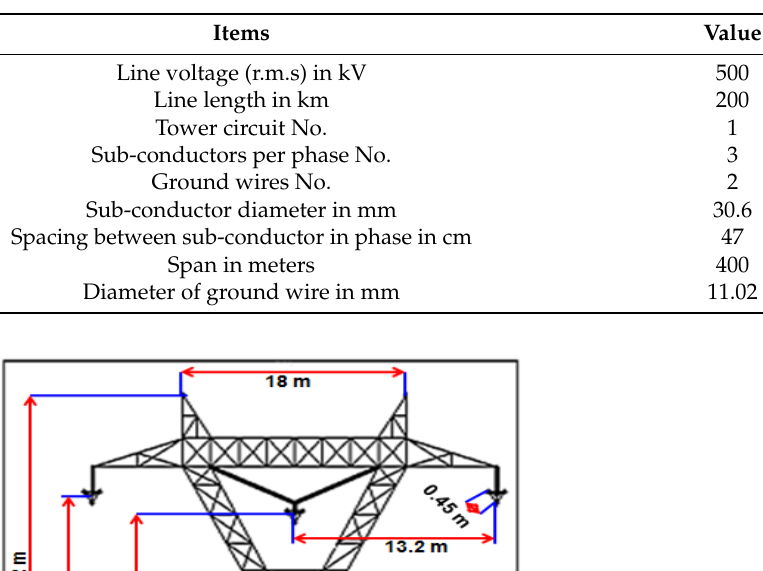
Table 1. The main parameters of the power line.